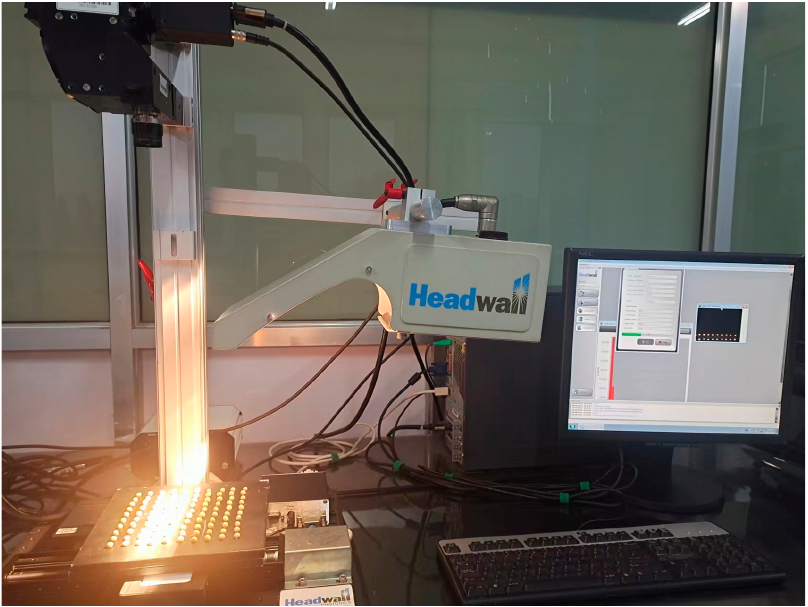
Figure 2. Hyperspectral data acquisition of corn leaves.